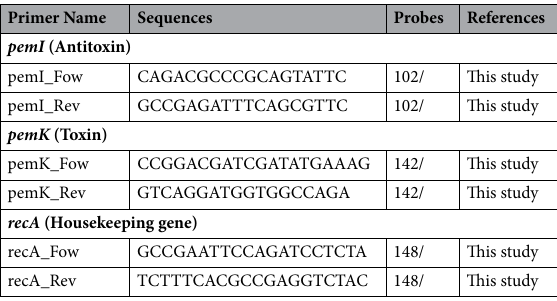
Table 4. Primers and probes used in this